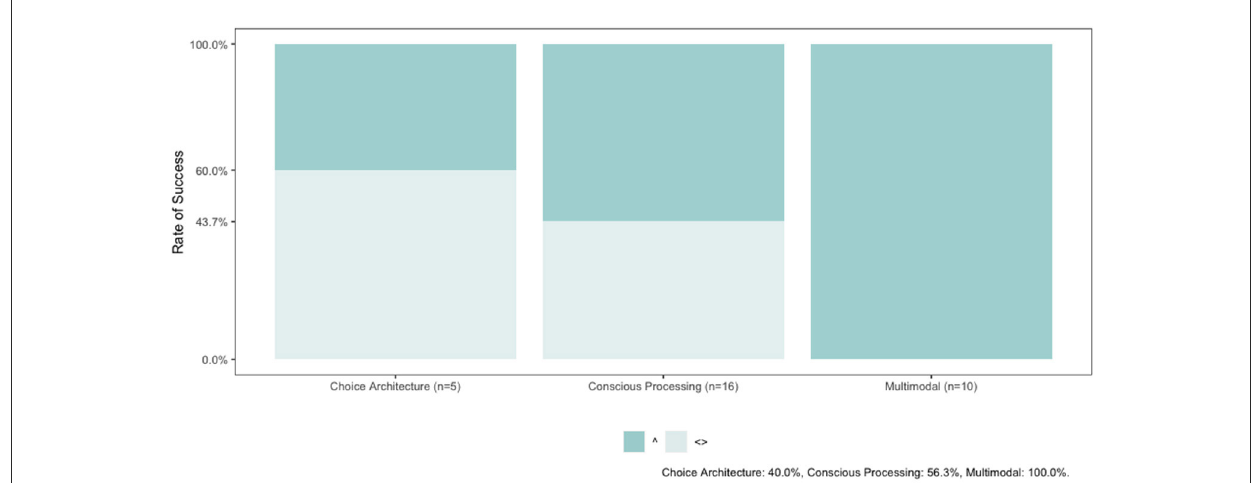
FIGURE4 Grouped bar graph comparing the proportion of interventions associated with significant reductions in meat consumption across each investigated approach. Relative to other approaches, multimodal interventions were more likely to lead to significant reductions in the amount of meat consumed within university settings ( p = 0.029). No increases in meat consumption were